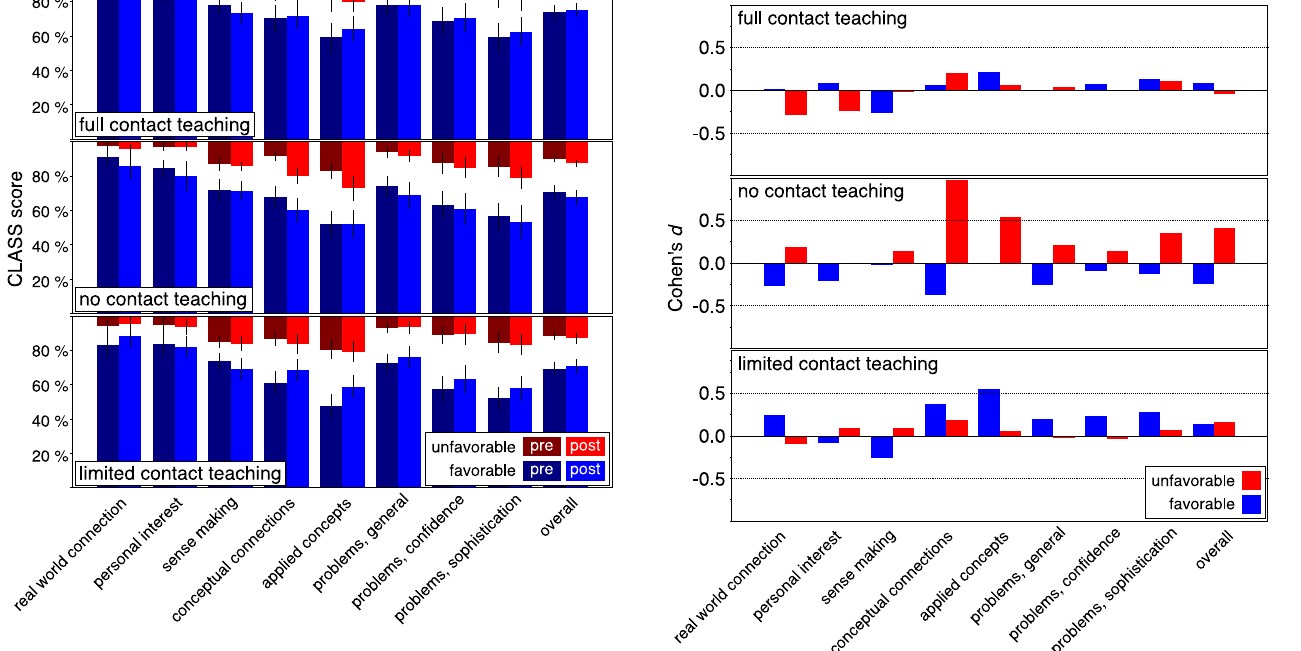
FIG. 1. Portion of expertlike (favorable) and nonexpertlike (unfavorable) answers in both pre- and postsurvey for different levels of contact teaching.